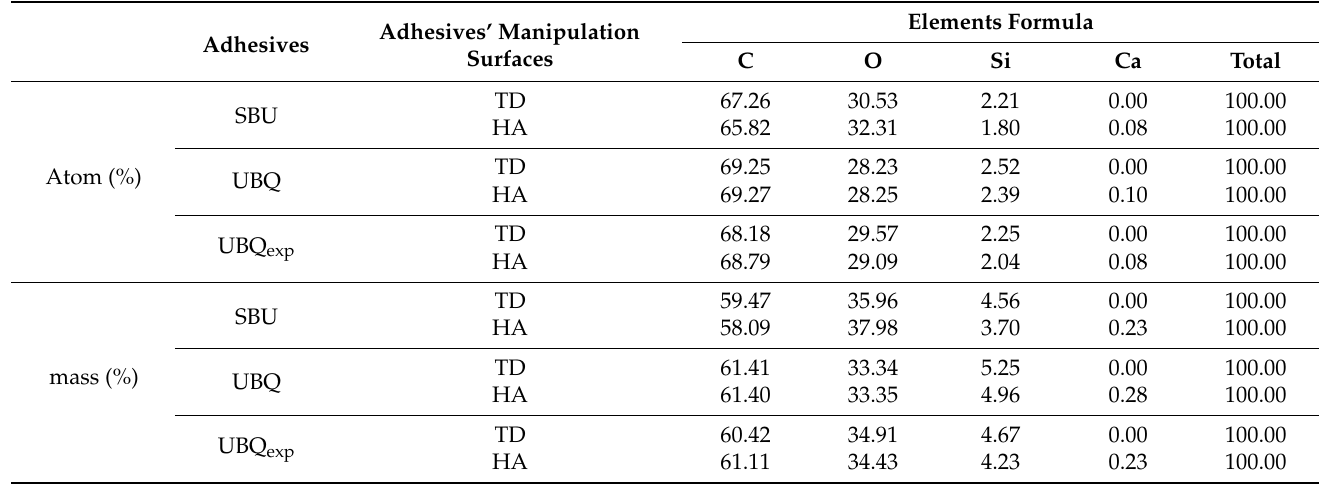
Table 6. The elemental composition of each 1-SEA manipulated in the manufacturers’ Teflon-based dispensing dish (TD) or the hydroxyapatite plate